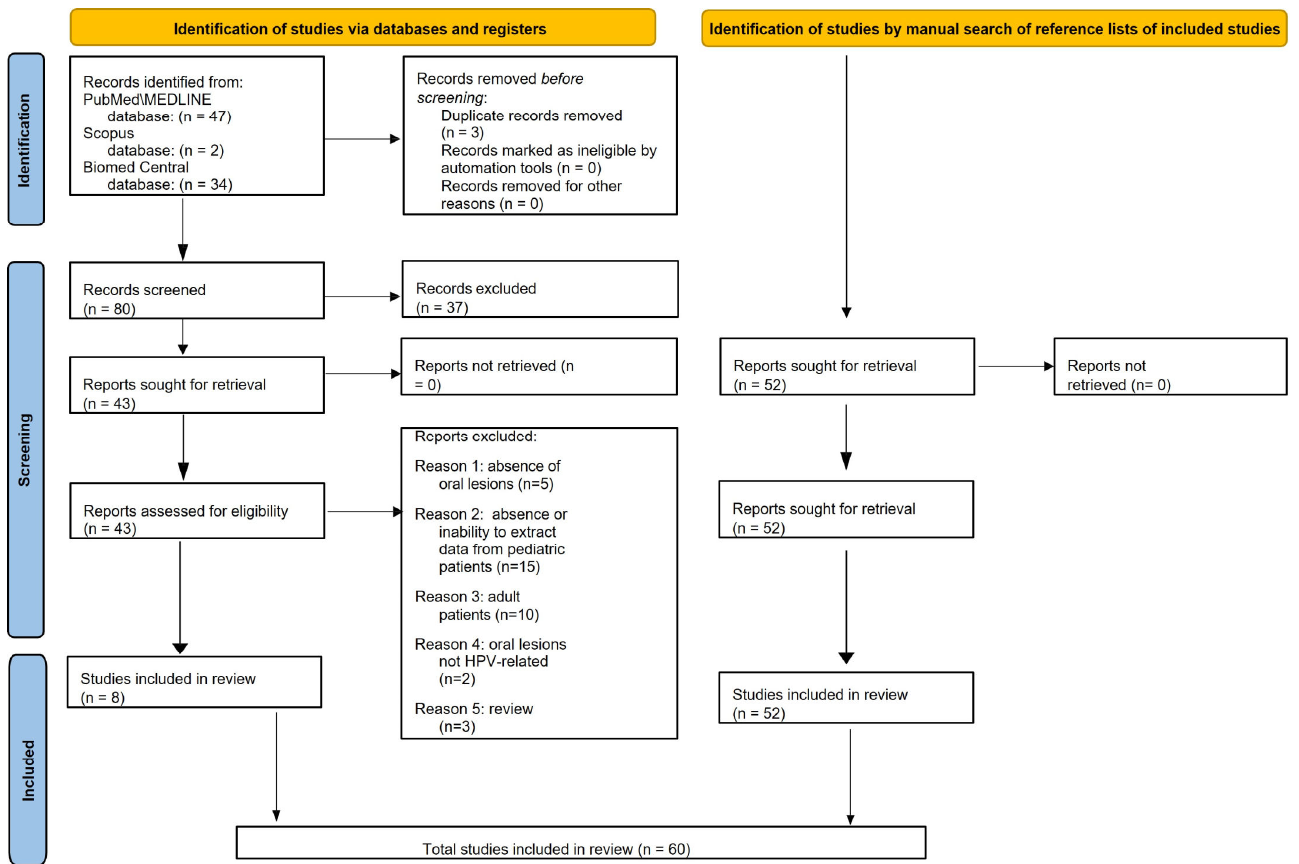
Figure 1. PRISMA 2020 flow diagram for electronically and manually retrieved records.